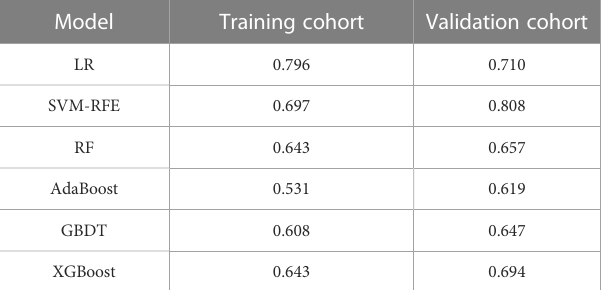
TABLE 3 AUC values of different prediction models for predicting the localized nephroblastoma.